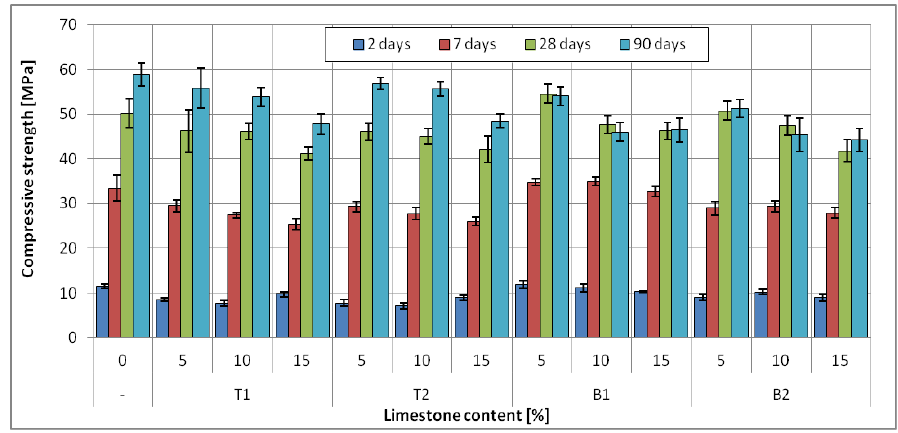
Figure 11. Compressive strength of blended slag-limestone cements made of CEM III/A 42.5N.